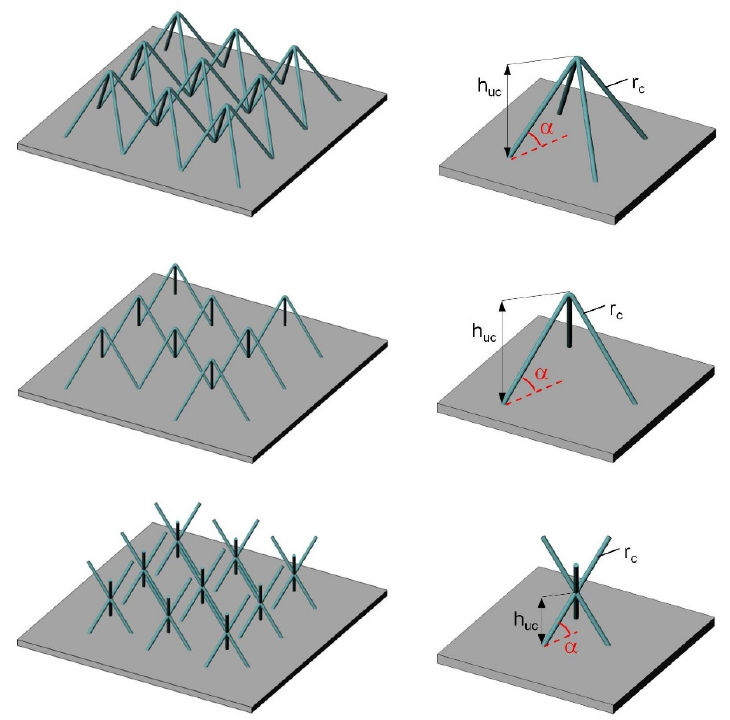
Figure 7. Sections of conventional one-layer 3D lattice core variants with their associated unit cells. From top to bottom: pyramidal core, tetrahedral core, and 3D Kagomé core [57]. Studies by Wadley et al. focused on determining the mechanical properties of sandwich constructions with pyramid ‐ shaped lattice core structures. The behavior of these sandwich structures under vertical compressive loading, as well as under longitu ‐ dinal and transverse shear loading, was documented in detail [58,59]. In addition, the geometry ‐ dependent failure patterns were investigated in [60], taking into account mul ‐ ti ‐ layer core assemblies under in ‐ plane compressive forces. An increase in the mechani ‐ cal performance of most lattice core structures can be achieved by using circular hollow sections for the lattice bars [61]. Similarly, the use of carbon ‐ fiber ‐ reinforced polymer as a core material promises higher performance potential [62]. Cyclic loading shows that, under shear stress, there is a high susceptibility to fatigue and failure in the brazed or welded connection areas between the core and the cover surface. However, hardly any structural problems were observed during compression processes [63]. Studies on the imperfection sensitivity of the core geometry confirmed the joints as critical regions. De ‐ liberately introduced imperfections in the connection regions led to a loss of shear strength and shear stiffness but did not show any effects in the case of vertical compres ‐ sive stresses [64]. Since finite ‐ element ‐ based simulations of complex core structures are very compu ‐ tationally expensive in terms of time and CPU capacity, the number of topologies con ‐ sidered in this contribution had to be limited. For this reason, a direct comparison with the previously described variants is not possible for the lattice cores. Rather, the focus here is on a subset of the novel cell geometries shown in Figure 8. The uppermost topol ‐ ogy corresponds to the equivalent of a three ‐ dimensional honeycomb cell and is charac ‐ terized by positive values of the lattice cell angle 𝛼 . With 𝛼 (cid:3404) 0° , cube ‐ shaped cells with ‐ out inclined cell components are created. A three ‐ dimensional auxetic structure results, with a value of 𝛼 in the negative value range (Figure 8, center). Here, a compression in one of the three spatial directions also leads to a contraction of the cell in the two re ‐ maining directions. Slight modifications transform the conventional pyramidal geome ‐